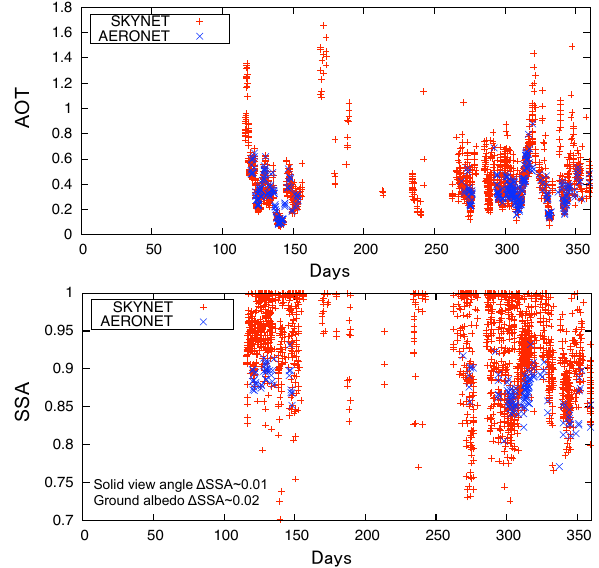
Fig. 1. Time series of AOT and SSA at a wavelength of 0.5µm at the Pune site. The upper and lower panels show AOT and SSA, respectively. The period is from April through December 2008. The horizontal axis is the time of Julian day from 1 January 2008. Daggers and crosses indicate the results of SKYNET retrieved by SKYRAD.pack version 4 and the results of AERONET, respec-